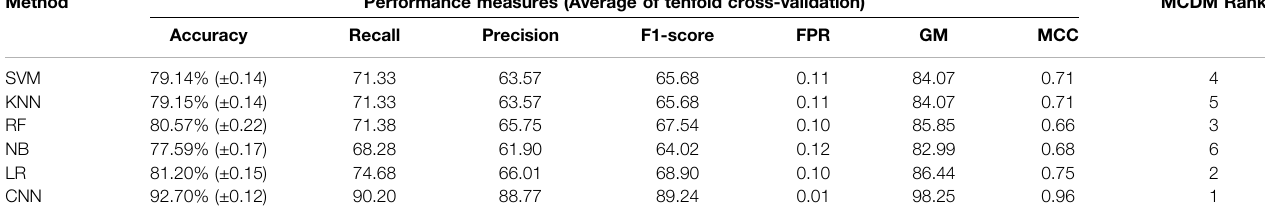
TABLE 2 | Models performance and ranking for validation data (transcriptome).